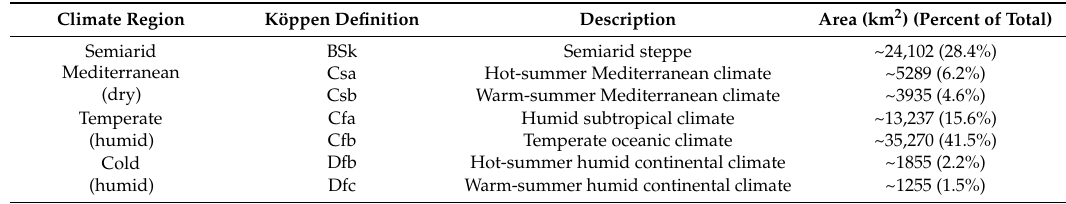
Table 1. Climate regions and area covered by each climate region according to Köppen classification.